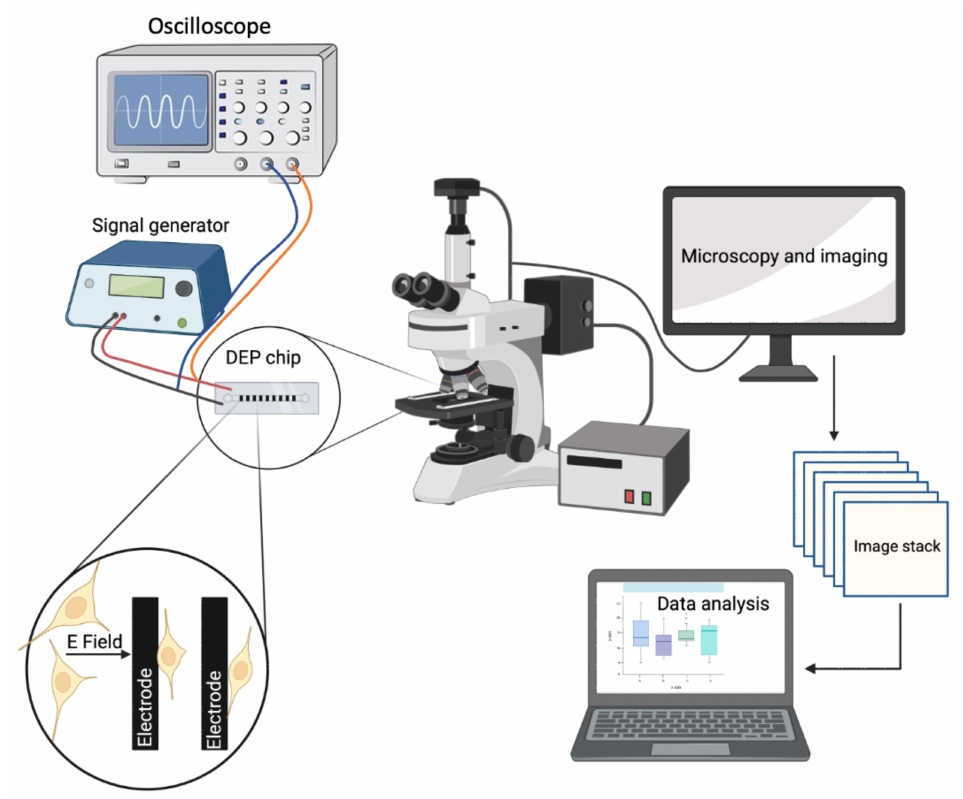
Figure 2. Schematic of the experimental setup including an oscilloscope, signal generator, DEP chip, table-top upright microscope, and a computer.